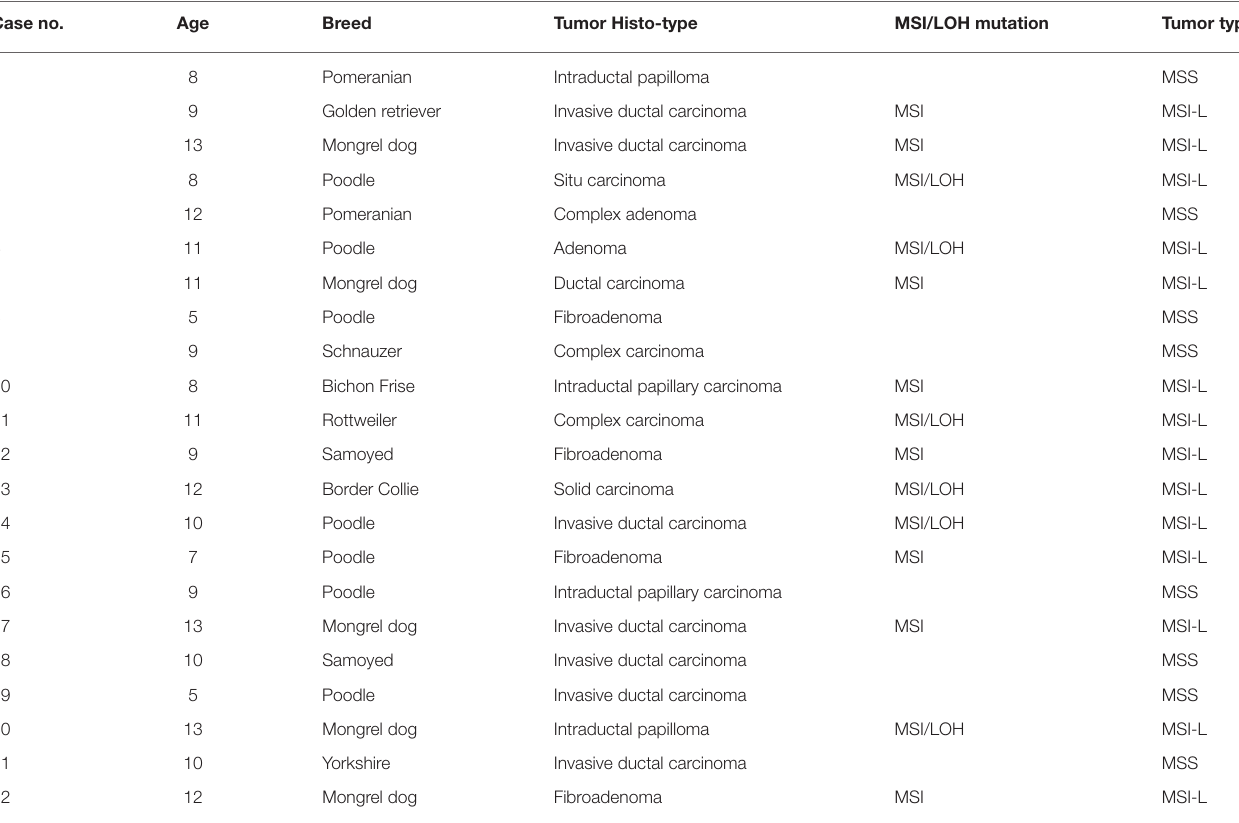
TABLE 2 | Information of canine mammary tumors. Case